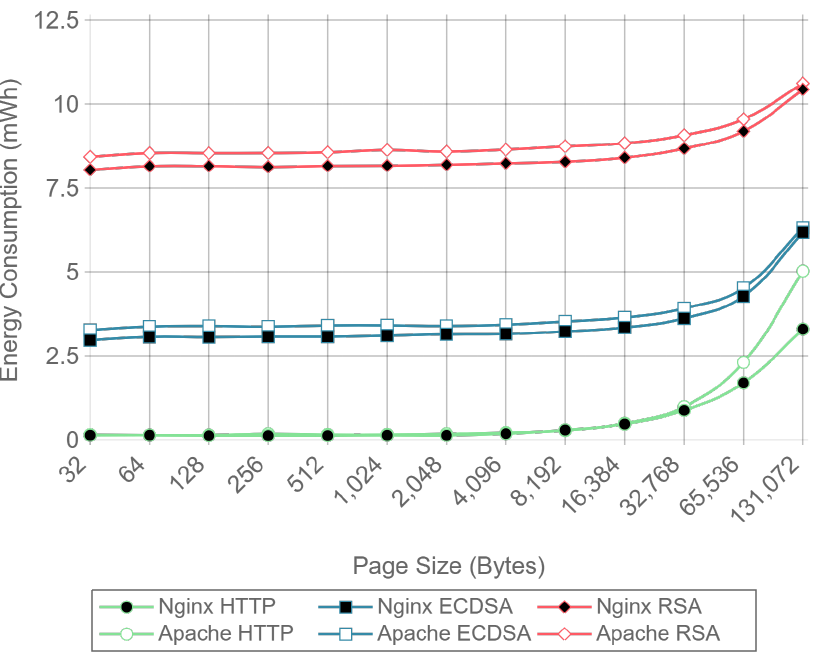
Figure 11. Server-side page size versus energy consumption for Apache2 and Nginx with 16 concurrent clients.